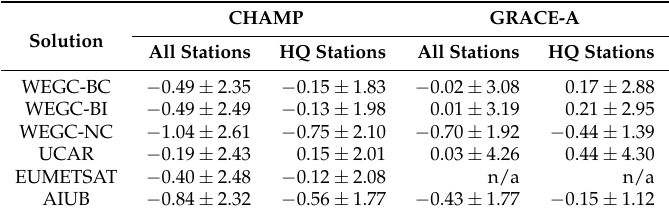
Table 4. Mean and standard deviation (in cm) of SLR residuals for the full set of SLR stations and selected high-quality (HQ) stations for CHAMP and GRACE-A in Jun/Jul/Aug 2008. CHAMP GRACE-A Solution All Stations HQ Stations All Stations HQ Stations WEGC-BC − 0.49 ± 2.35